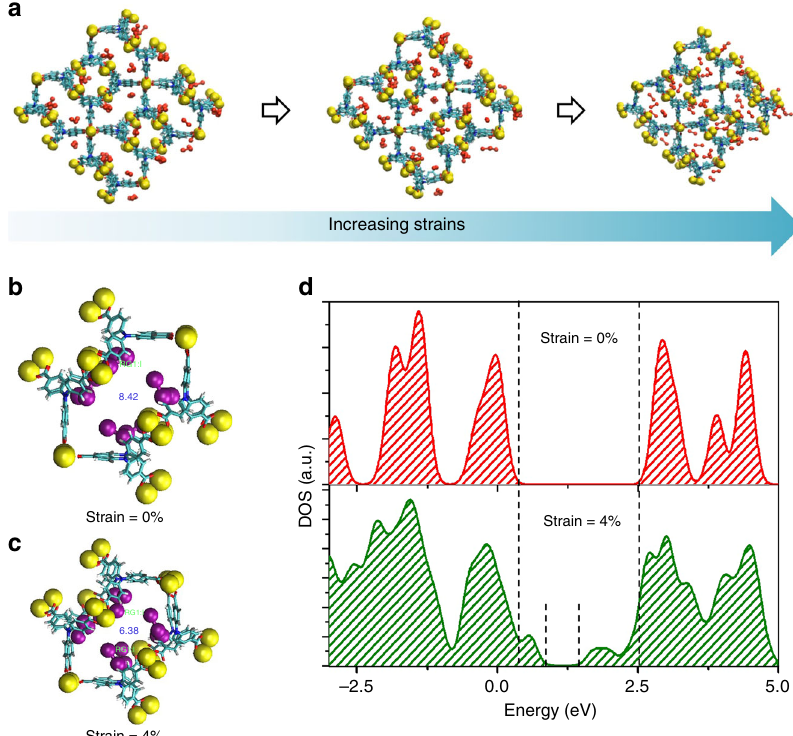
Fig. 2 Evolution of the crystalline and electronic structures of I 2 @CuTCA. a Shrinkage of the I 2 @CuTCA framework under increasing strains. b , c Inter-atom distances between the neighboring I 2 hopping sites in I 2 @CuTCA under the bending strains of 0 and 4%, respectively. In b , the iodine atoms are highlighted in purple spheres for a better illustration. d Local density of states (DOS) of I 2 @CuTCA under the bending strain of 0% and 4%,